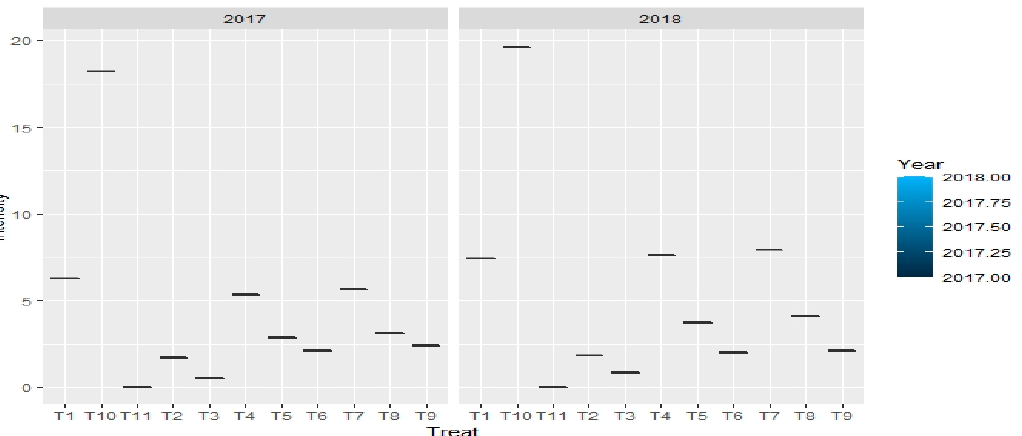
Figure 4. Impact of non-systemic fungitoxicants in casing on percent intensity of green mold disease of button mushroom, where T1 = Prochloraz manganese 0.05% conc., T10 = Check I(infested-untreated), T11 = Check II (uninfested-untreated), T2 = Prochloraz manganese 0.1% conc., T3 = Prochloraz manganese 0.2% conc., T4 = Chlorothalonil 0.05% conc., T5 = Chlorothalonil 0.1% conc., T6 = Chlorothalonil 0.2% conc., T7 = Captan 0.05% conc., T8 = Captan 0.1% conc., T9 = Captan 0.2% conc.